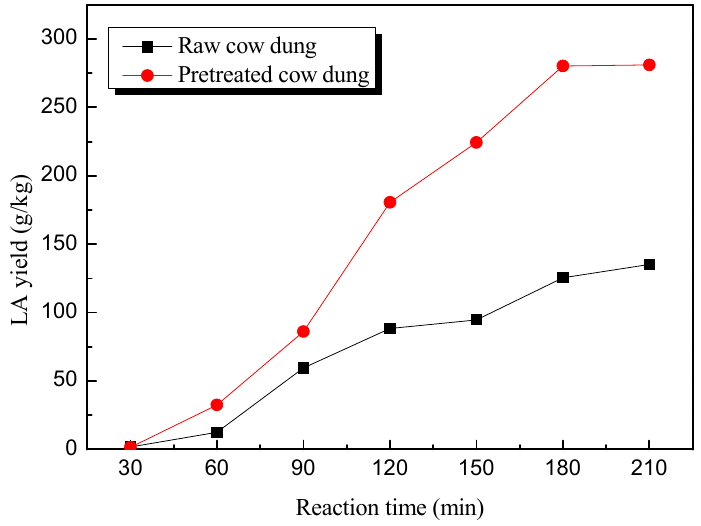
Figure 3. Catalytic production of LA from cow dung with and without pretreatment in HCl aqueous solutions (reaction conditions: 0.3 g substrate, 0.2 M HCl aqueous solution 10 mL, 180 °C).